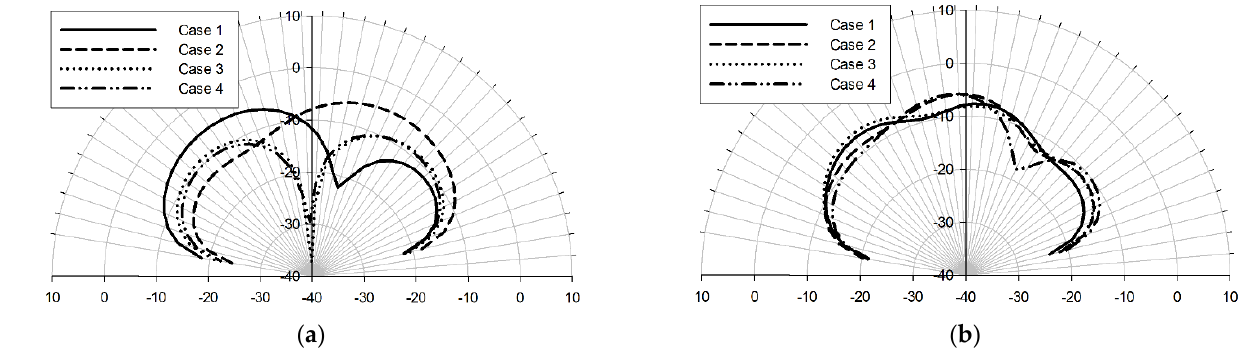
Figure 12. E-plane (xz-plane) ( a ) and H-plane (yz-plane) ( b ) characteristics of the pixel antenna when S2 = Sc1 = Sc2 = S9 = ON (case1), S1 = Sc1 = S6 = S8 = ON (case2), Sc1 = Sc2 = S9 = S10 = ON (case3) and Sc1 = S5 = S7 = S9 = S6 = S8 = S10 = ON (case4) at 50 THz.